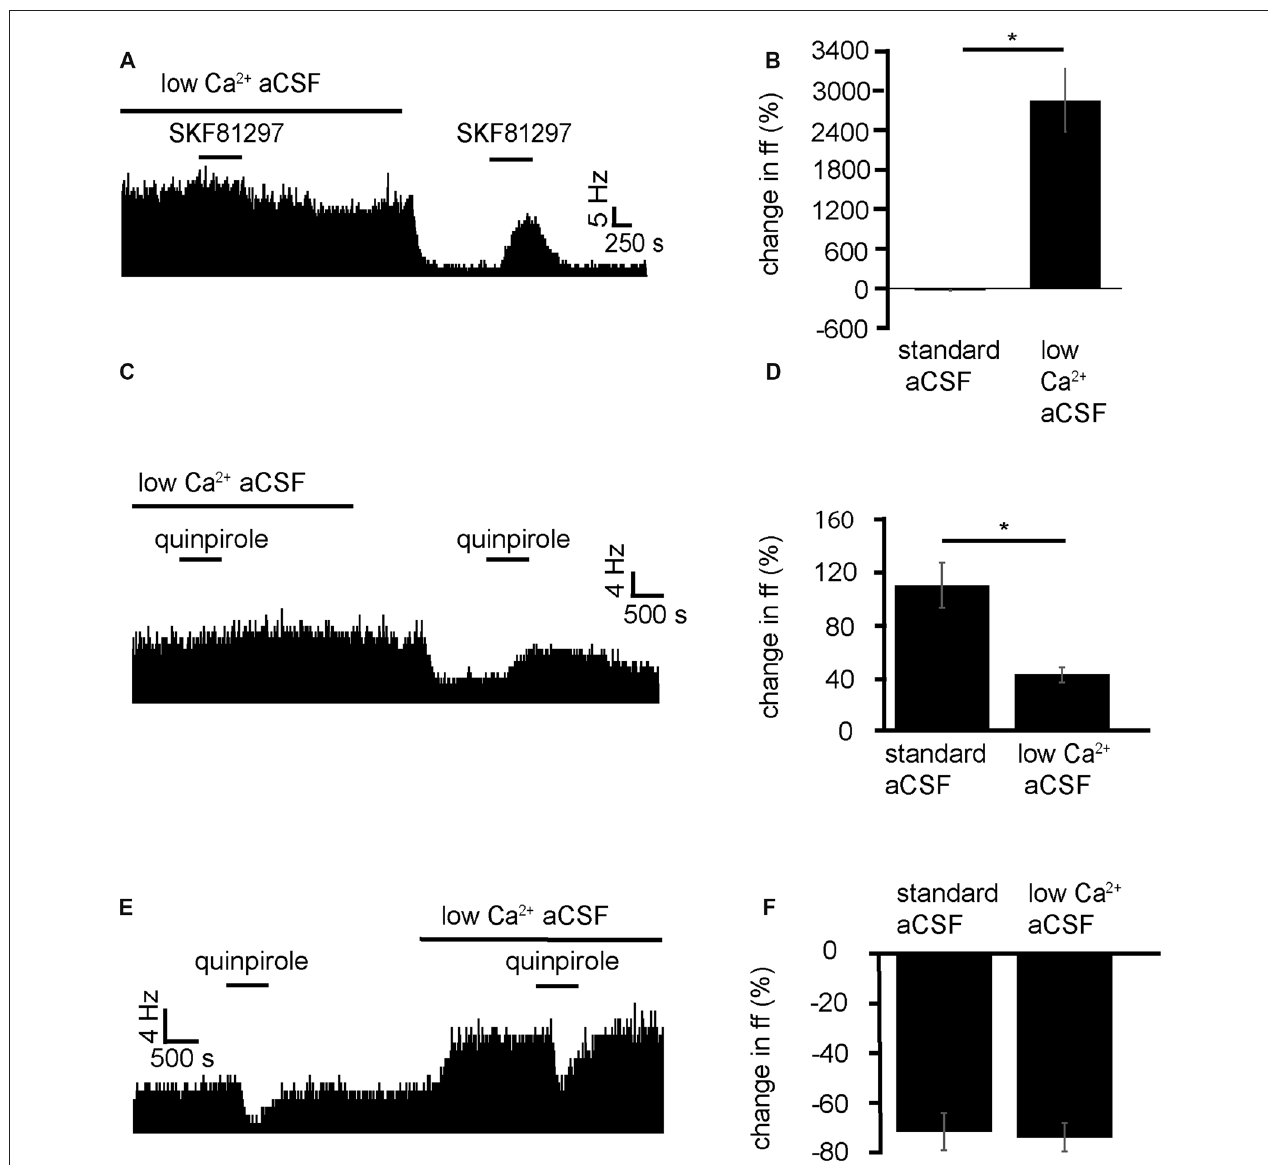
FIGURE 6 | Low Ca 2 + aCSF blocks the excitatory effects of D1-like and D2-like receptor agonists but not the inhibitory effects of D2-like receptor agonists. (A) Excitatory response to SKF81297 application in standard aCSF, which is not present in low Ca 2 + . (B) Significant differences in firing frequency for SKF81297 application in low Ca 2 + compared to the application of SKF81297 in standard aCSF. (C) Excitatory responses to quinpirole application alone were occluded in response to quinpirole application in low Ca 2 + aCSF. (D) Significant difference in firing frequency for quinpirole application alone compared to